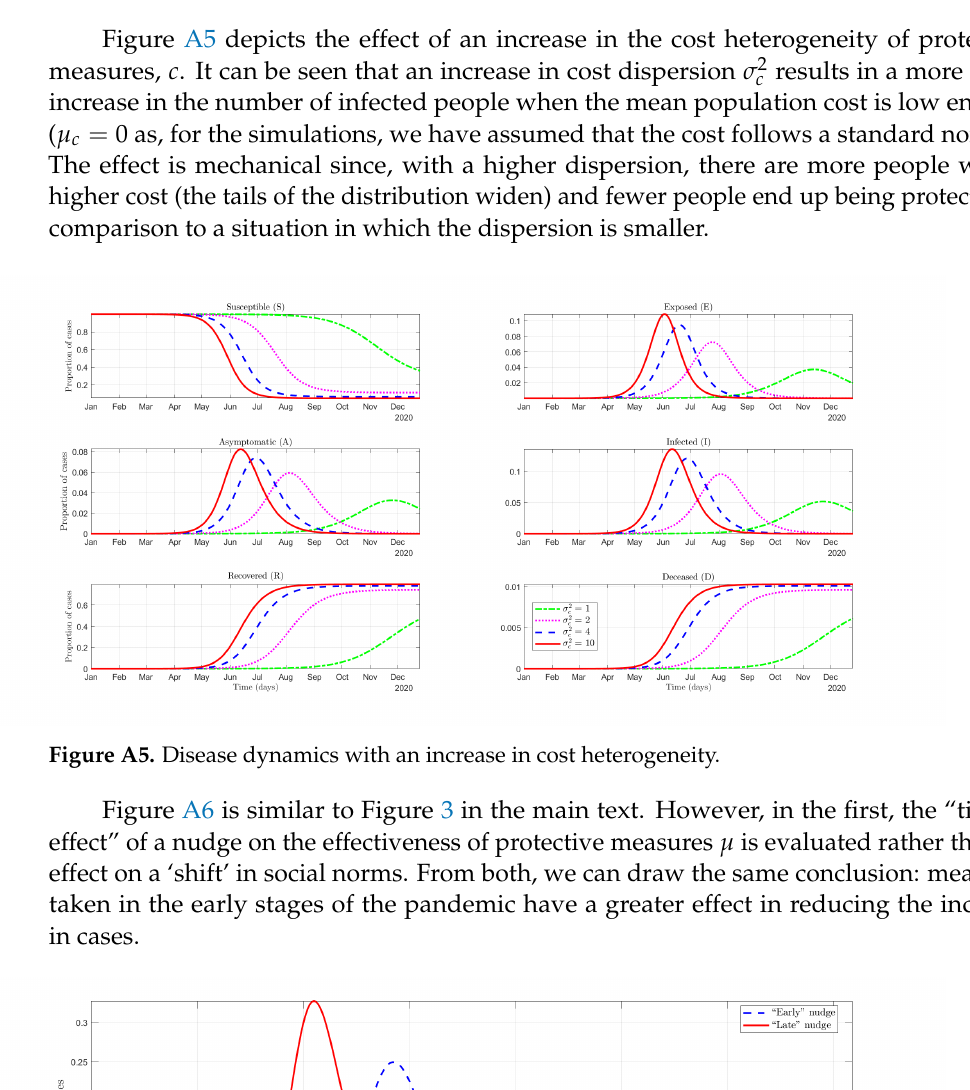
Figure A4. Exogenous lockdown vs. Non-lockdown.